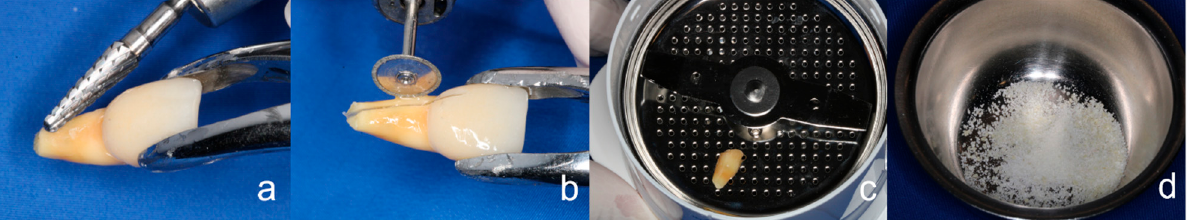
Figure 1. Processing procedure: ( a ) Removal of periodontal structures, root filling, and deposits using rotating diamonds; ( b ) Separation of a dentin shell; ( c ) Particulation of the remaining tooth with the smart grinder; ( d ) Particulated material in a sterile tray.